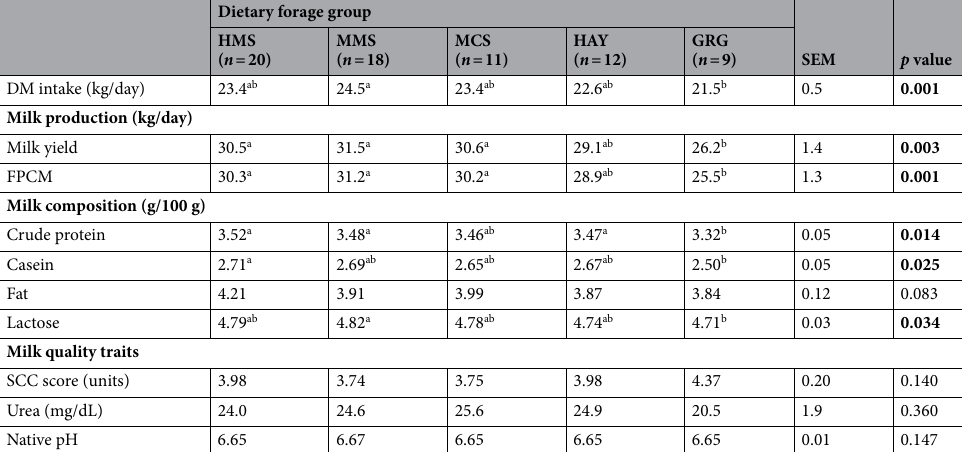
Table 2. Effect of dietary roughage source (forage group) on DM intake (DMI), milk production, composition and quality traits. FPCM , fat protein corrected milk (4.0% fat and 3.3% true protein); SCC , somatic cell count as log 2 (SCC/100,000) + 3; HMS , high maize silage; MMS , medium maize silage; MCS , mixed crop silages; HAY , grass and lucerne hays; GRG , green grass; SEM , standard error of the means. a-b LSMeans in a row without a common superscript differ ( p <